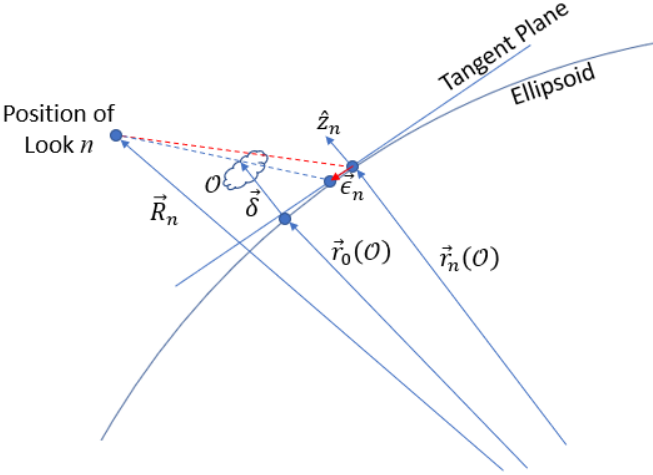
Figure 5. The MISR-GOES 3D-winds retrieval model is reused for MODIS and GOES. The n = 0 reference image provides a template for the feature O with nominal location where it projects onto the ellipsoid as seen from camera look n = 0. The ellipsoid location of the matched feature in n ≠ 0 is determined from the measured disparity between n ≠ 0 and n = 0. The model minimizes the weighted sum of the squares across all looks of the calculated di ff erences n . Each n measures the difference in the tangent plane for n ≠ 0 between where the model places the feature and where it was actually found. The minimization uses five model states for each retrieval and the problem is solved by iterative refinement of the states until converged because the problem is slightly nonlinear. Three position states δ 0 describe the displacement of the template from its nominal location on the ellipsoid r 0 ( O ) at the assigned time tag t 0 for the template. The vertical component of 0 is the height assignment. Two more states describe the motion of the template (wind) so that its instanteous displacement is δ = δ + v · ( t − t 0 ) , where v is an AMV describing horizontal motion.